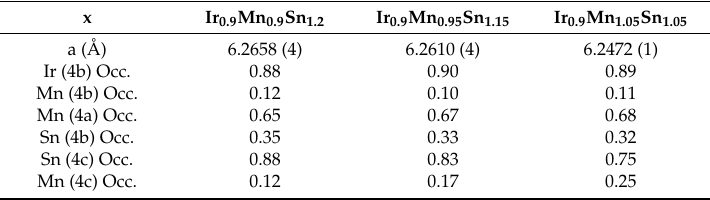
Table 1. The lattice parameters and site occupancies of Ir 0.9 Mn 1 − x Sn 1.1+x .